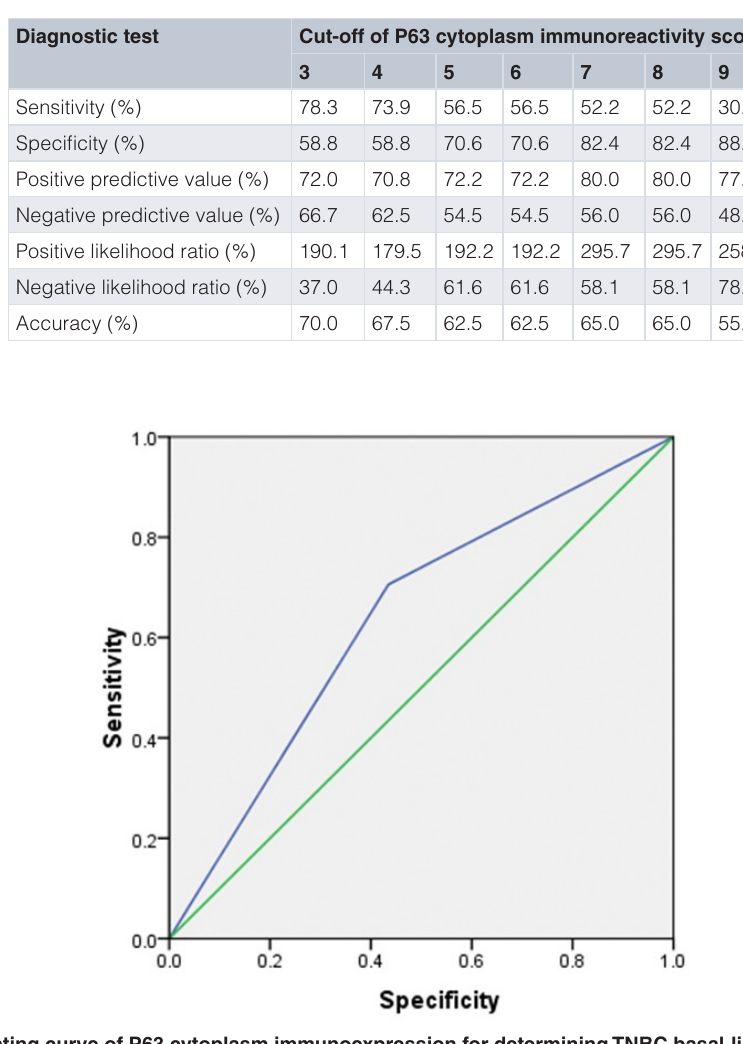
Figure 1. Receiver operating curve of P63 cytoplasm immunoexpression for determining TNBC basal-like type.